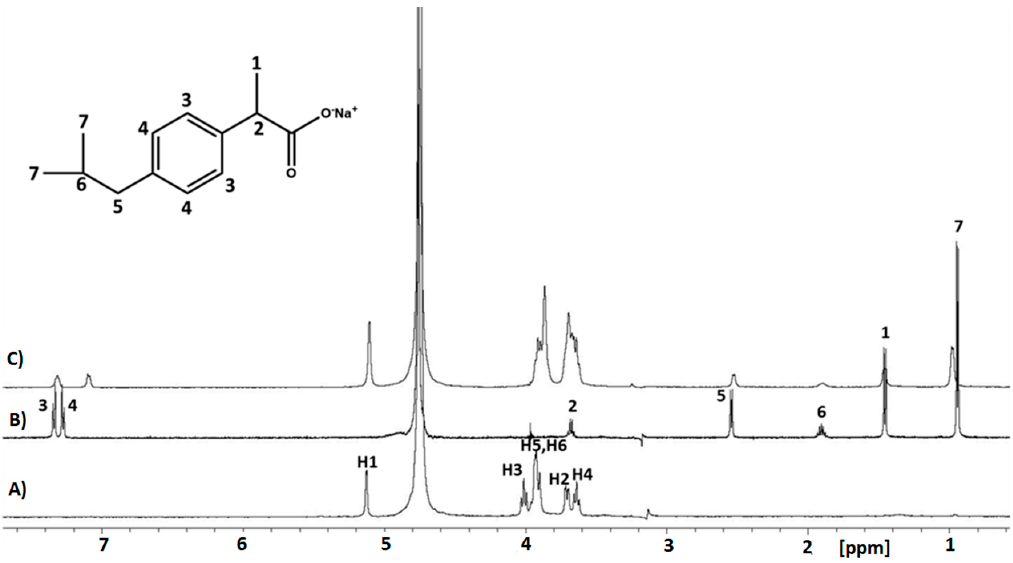
Figure 5. 1 H high-resolution magic angle spinning (HR-MAS) NMR spectra of: A ) β -cyclodextrin ( β